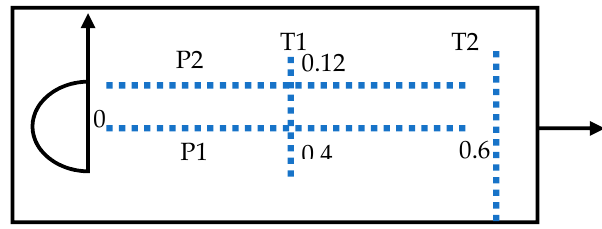
Figure 22. The arrangement of the receiver points on the panel.